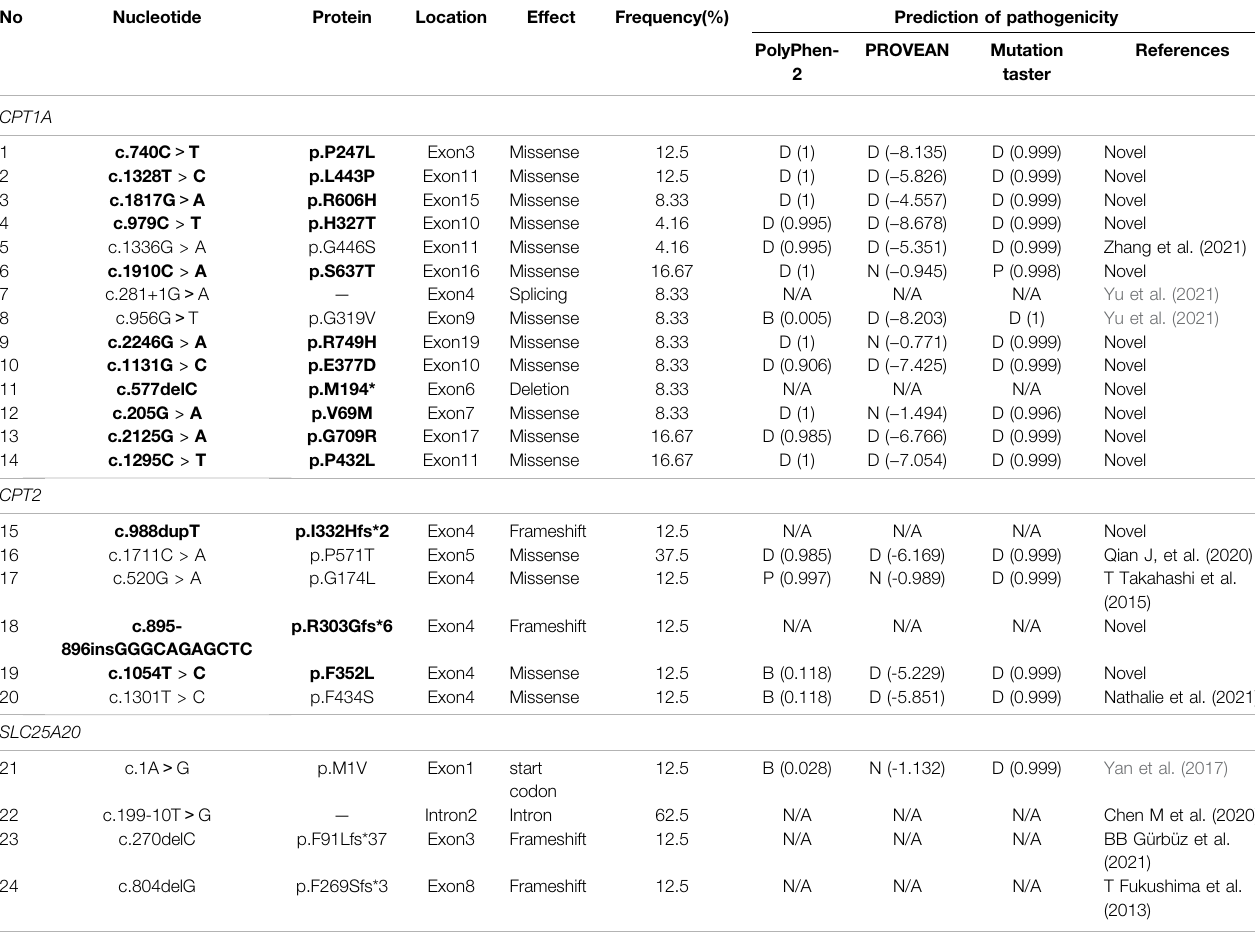
TABLE 3 | Variants detected in con fi rmed patients with CPT1D, CPT2D, CACTD. No